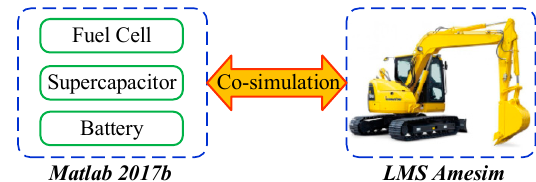
Figure 12. Co-simulation environment. Energies 2019 , 12 , x FOR PEER REVIEW